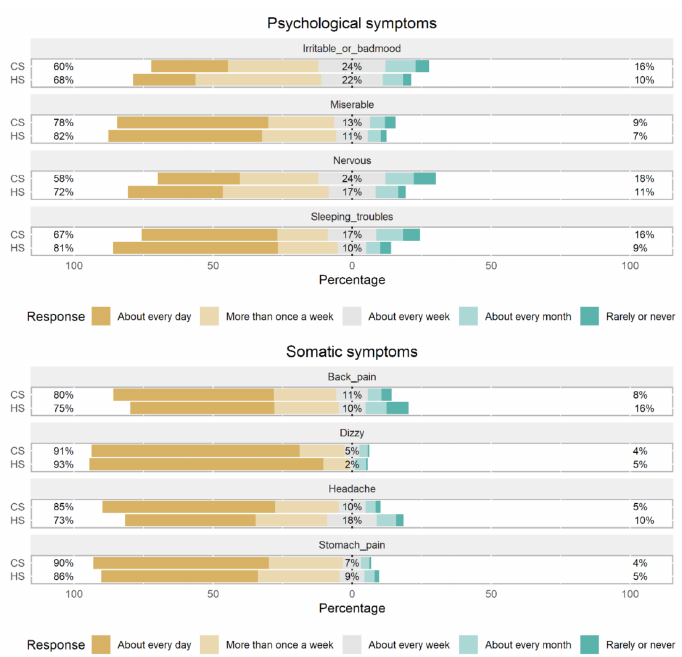
Figure 2. Distribution of responses representing the self-reported frequency of psychological and somatic symptoms for computer science (CS) and health science (HS)